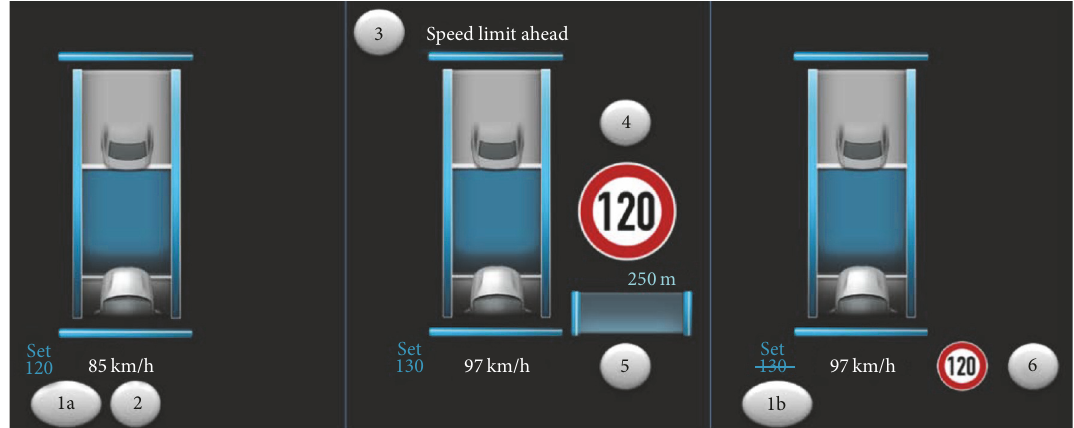
Figure 2: HMI for communication of speed limits.